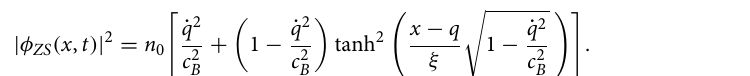
(cid:31) / √ mn n 0 g / m . The width and the depth of solitonic 0 g and c B = = (cid:31)